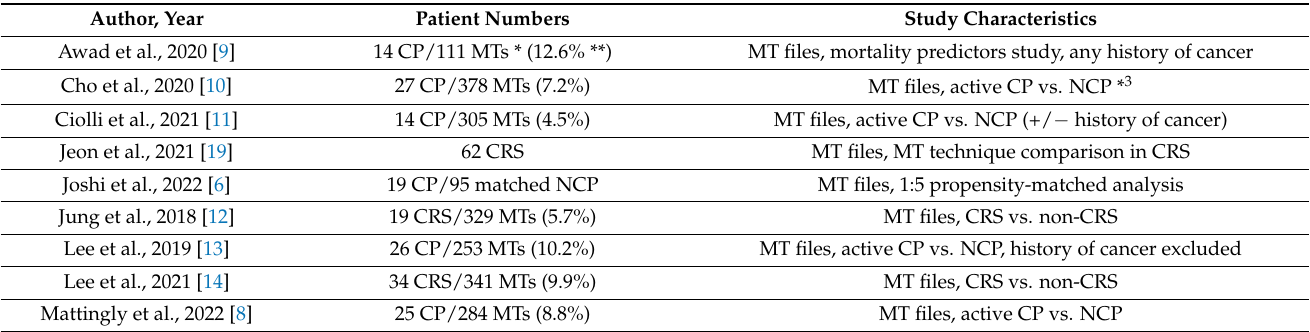
Table 1. Included Studies, Study Characteristics, and Cancer Patient